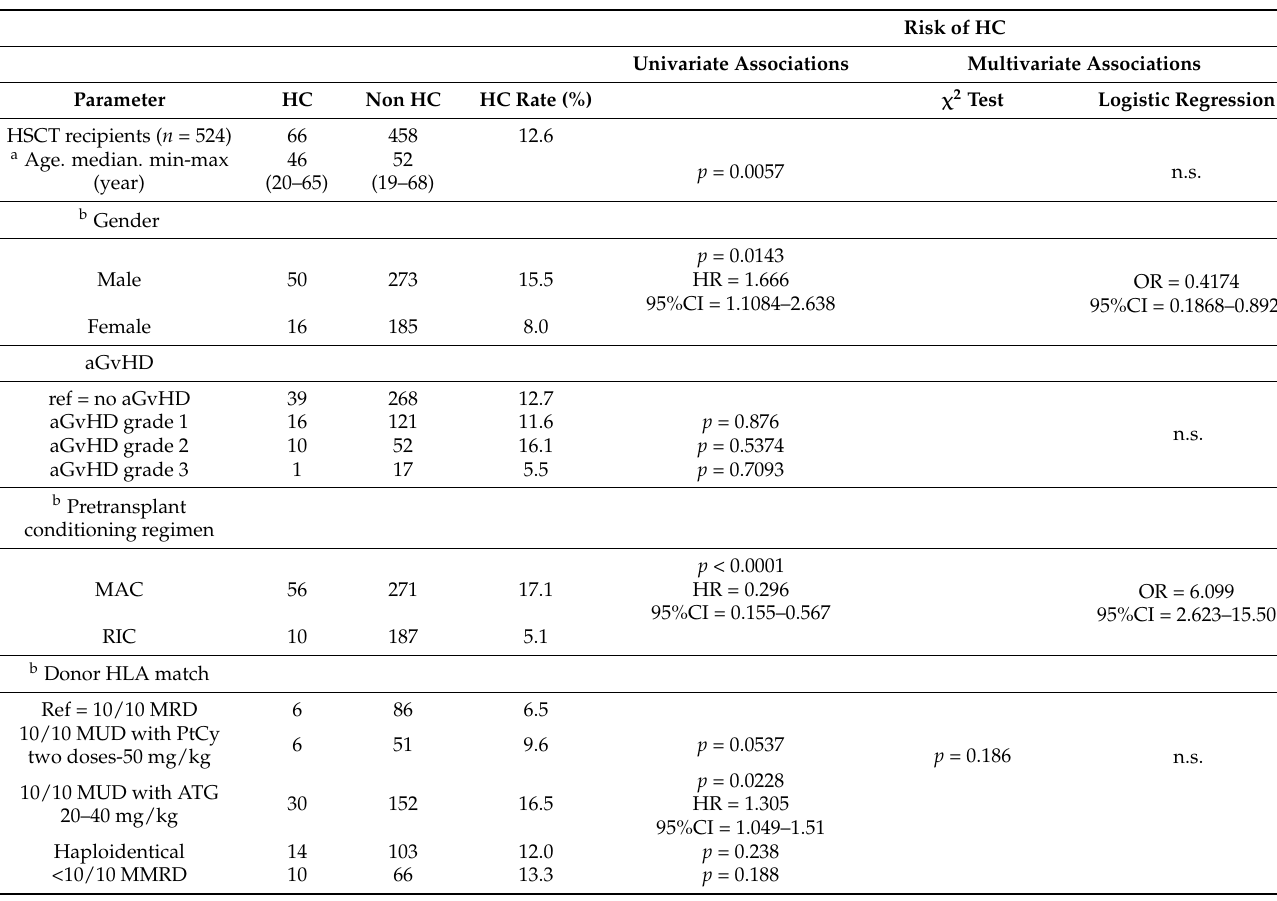
Table 1. Retrospective analysis of the risk of HC in a cohort of HSCT recipients transplanted during the period 2014–2020 ( n = 524) and clinical features of BKPyV reactivation. Risk of HC Univariate Associations Multivariate